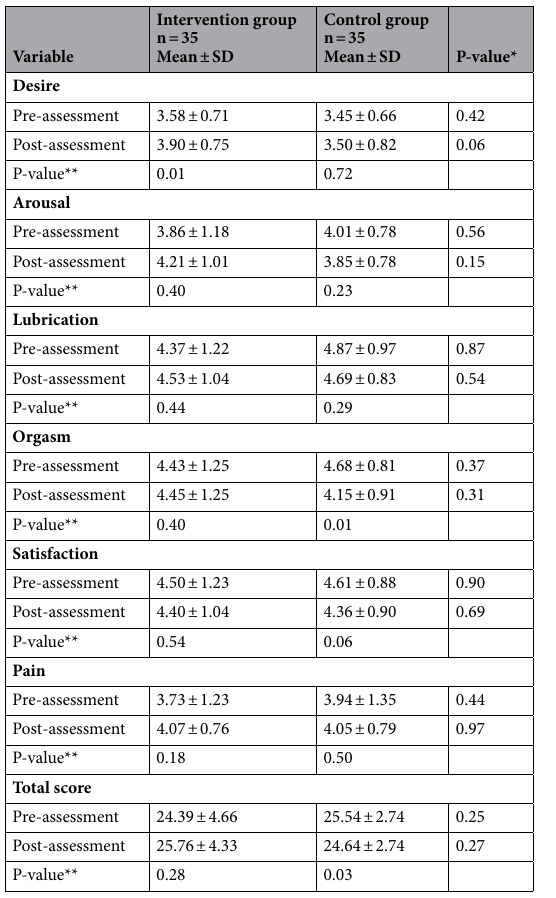
Table 2. Comparison of FSFI scores between intervention and control groups. FSFI Female Sexual Function Index. *T-test was carried out for comparison of the groups. **Paired T-test was carried out for comparison of changes between the